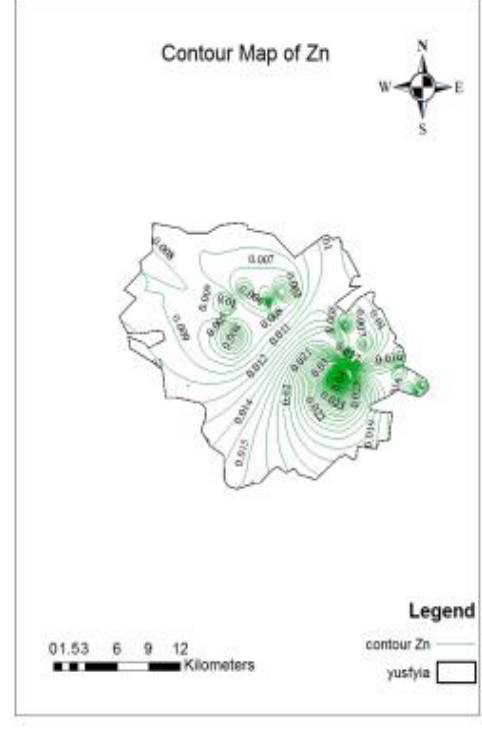
Fig.17: The interpolation and contour line of Zn map in